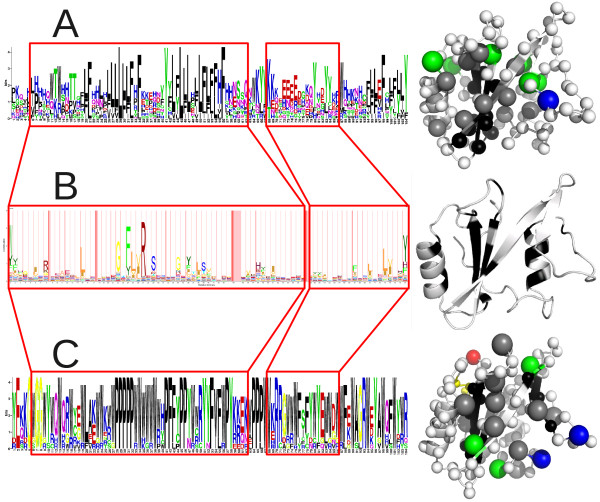
A comparison of simulated sequences and structures with those of known SH2 proteins is shown. A) and C) depict sequences simulated under the informational and physics-based models, respectively, while B) depicts the SH2 family from the Pfam database. Residue frequency distributions are shown on the left as sequence logos for A) and C), and as HMM emission probabilities for B). Red boxes indicate matching positions between the sequences. For A) and C), positions with more than 2 and 3 bits of information, respectively, were mapped onto the SH2 structure on the right with equivalent colors (white beads indicate less informative positions). For B), the 25 most probable positions were colored black on the backbone (remaining positions again in white).